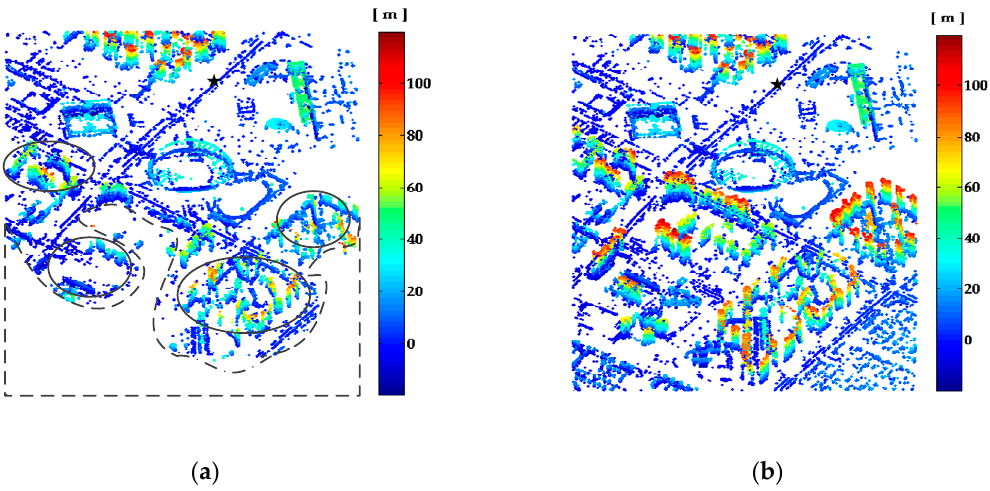
Figure 11. Estimated height of merged PSs. ( a ) Estimated height of merged PSs by traditional two-tier network; ( b ) estimated height of merged PSs by novel two-tier network.